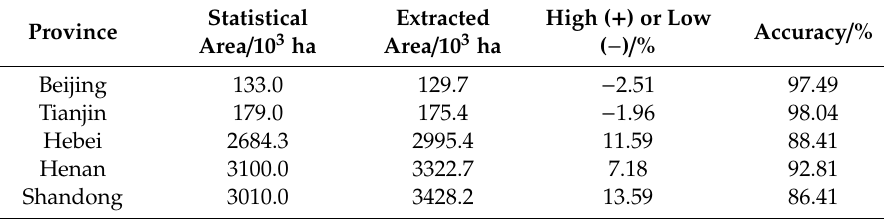
Table 5. Comparison of extracted area and statistical data of summer maize for each province in 2012. Province